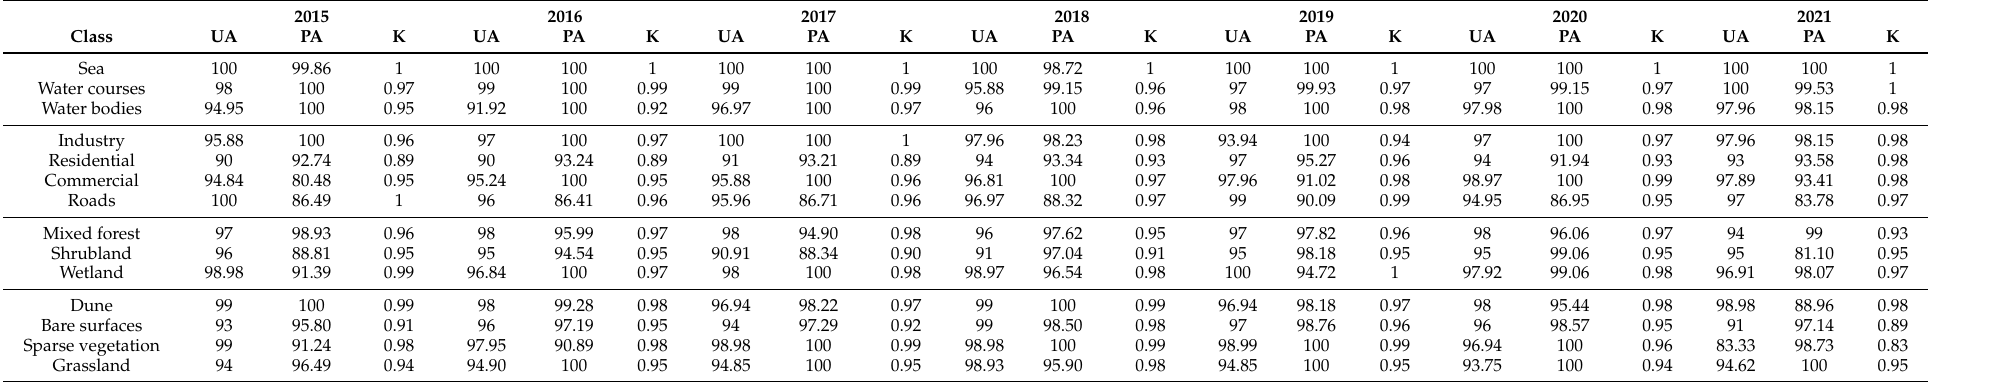
Table A1. Precision assessment of the LULC maps of the city of Coatzacoalcos.